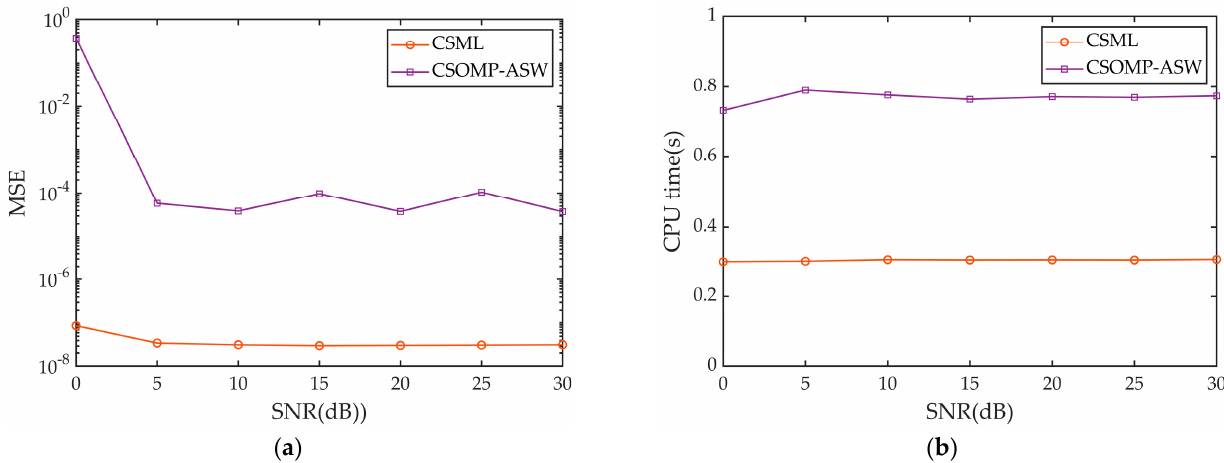
Figure 17. Performance of two algorithms when estimating hopping time. ( a ) The MSEs of the two algorithms for hopping-time estimation. ( b ) CPU time consumed by both algorithms in the process of estimating the hopping time.